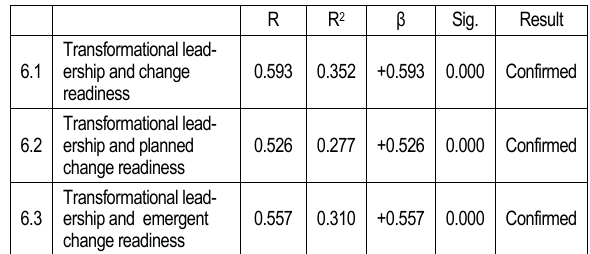
Table 7. Regression